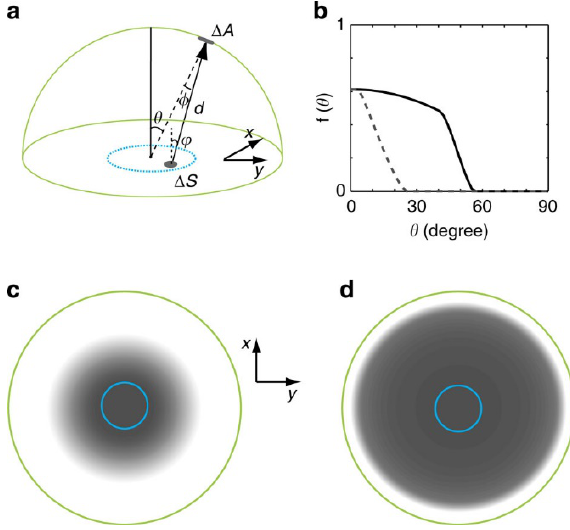
Figure 4: Distribution of thermal radiation on the surface of the extraction dome. (a) Schematic of the calculation. Solid arrow in- dicates radiation that is emitted from a small area ∆ S on the cavity opening and is received by a small area ∆ A on the surface of the dome. (b) Distribution of the radiation power on the surface of the dome as a function of the polar angle y. Dashed and solid lines are for the cases with empty and filled cavities, respectively. (c, d) The distribution of the radiation power, plotted on the hemisphere of the dome, for the case of empty (c) and filled (d) cavity. The blue cir- cle indicates the emitter area, that is, the opening area of the cavity. The green circle is the boundary of the dome. The darker region in- dicates higher emission and the white region has zero emission